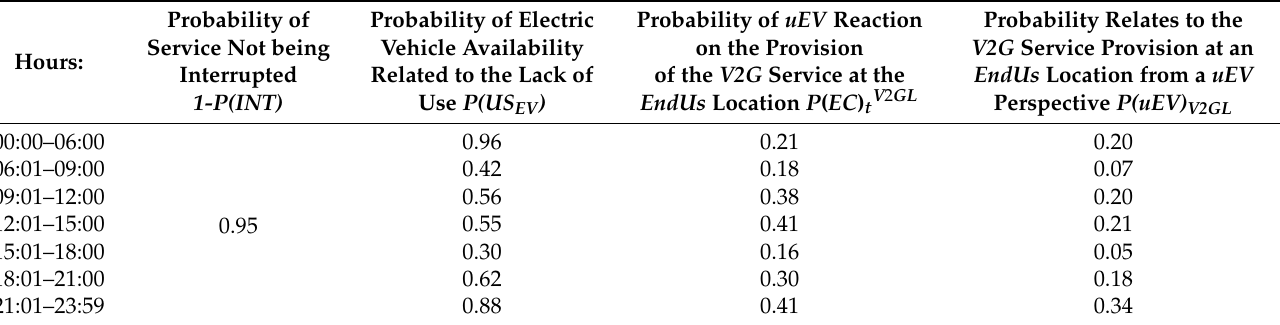
Table 4. Calculation of probability values P(uEV)